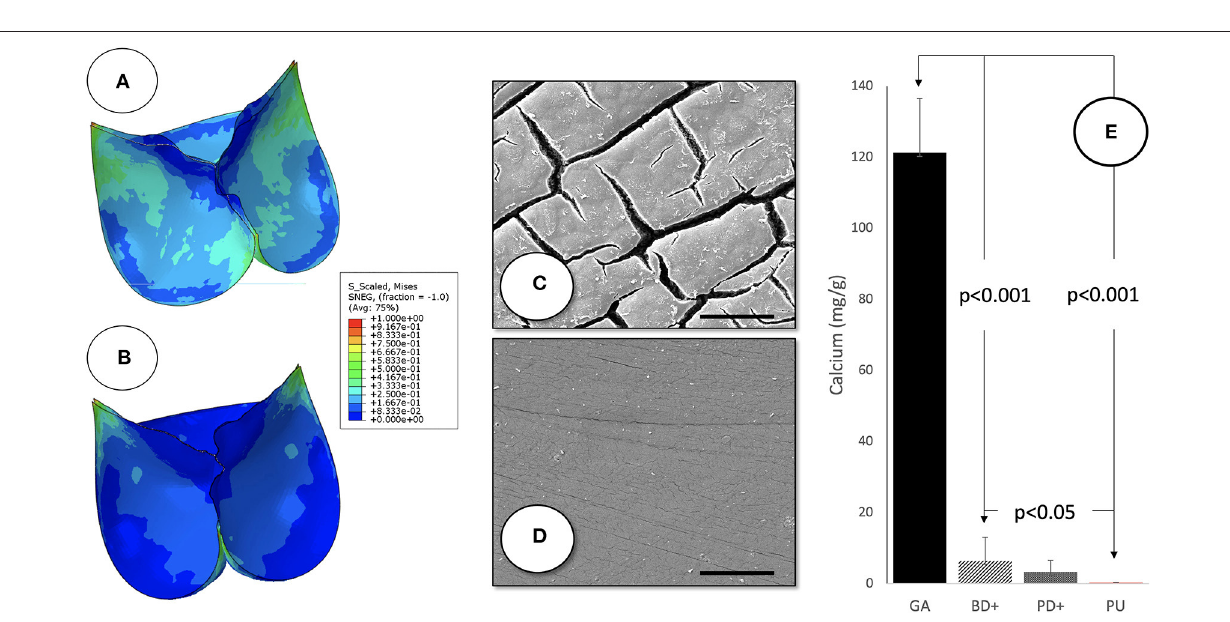
FIGURE 3 | Leaflet characteristics of SAT TAVR: normalized Von Mises stress of the PU (A) and BP (B) leaflets in the closed position shown as a contour plot of FEA results. Scanning electron micrographs of 100% pre-strained polyurethane leaflet films after 25 weeks of subcutaneous implantation in long-Evans rats demonstrating the degradation resistance of the SAT Carbosil leaflets (D) compared to significant surface degradation visible on the Pellethane control samples (C) (5,000 × ; Scale bar = 10 µ m). While calcification (E) was distinctly reduced in the decellularized, sandwich-crosslinked bioprosthetic leaflets (D) both in bovine ( − 95%; left) and porcine ( − 97% right) pericardium compared to the control group (GA), Calcium levels were almost undetectable in the group of pre-strained Carbosil